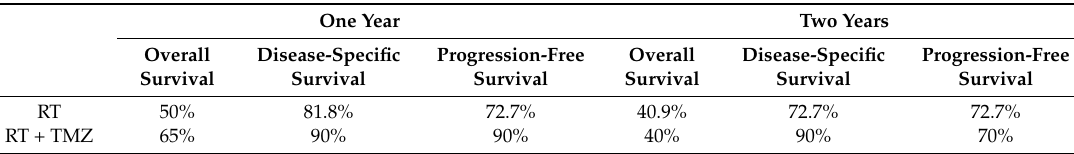
Table 2. Survival in the RT and RT + TMZ